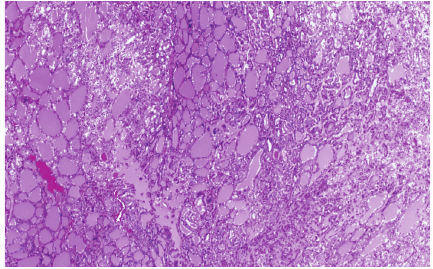
Figure 2: Hematoxylin and Eosin staining showing follicular pattern of papillary thyroid carcinoma (the first case).